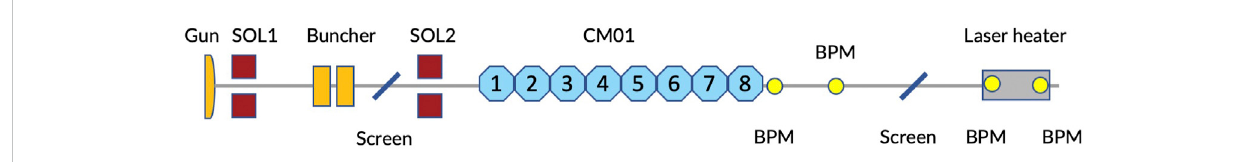
FIGURE 1 A schematic layout of the VHF gun photoinjector for LCLS-II.